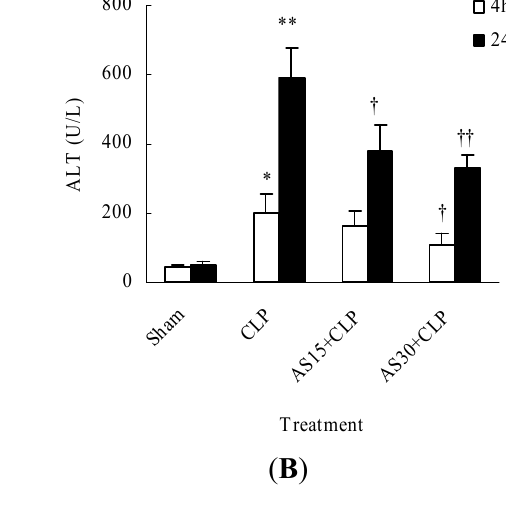
Figure 4. Effect of AS on serum AST ( A ) and ALT ( B ) activity of CLP mice. Thirty-two mice were randomly divided into 4 groups. At 4 and 24 h after operation, four mice from each group were sacrificed, respectively. Sera were separated from the blood samples by centrifugation, aliquoted and stored at − 80 °C for subsequent enzyme activity assay. Serum activity of AST and ALT were measured using spectrophotometric diagnostic kits. * p < 0.05, ** p < 0.01 as compared to the Sham group; † p < 0.05 and †† p < 0.01 as compared to CLP group. Other details are as described under Materials and